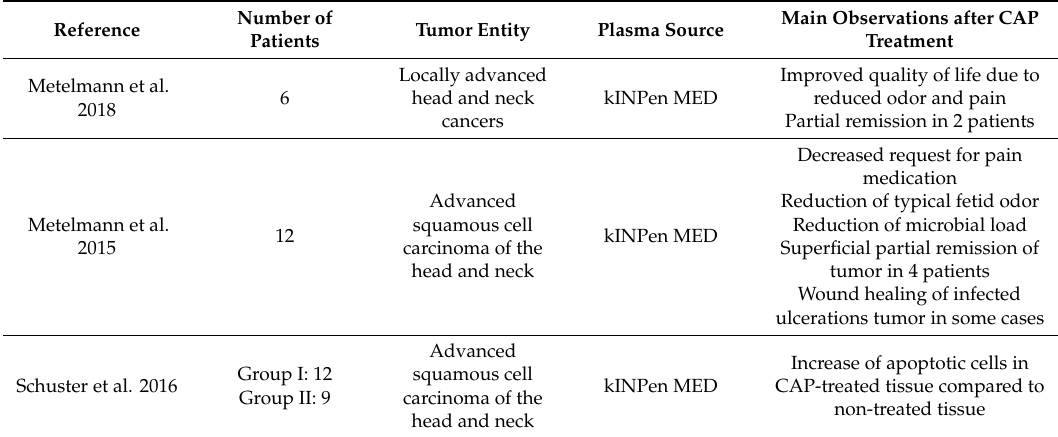
Table 1. Clinical studies reporting the use of CAP for treatment of (pre-) cancerous